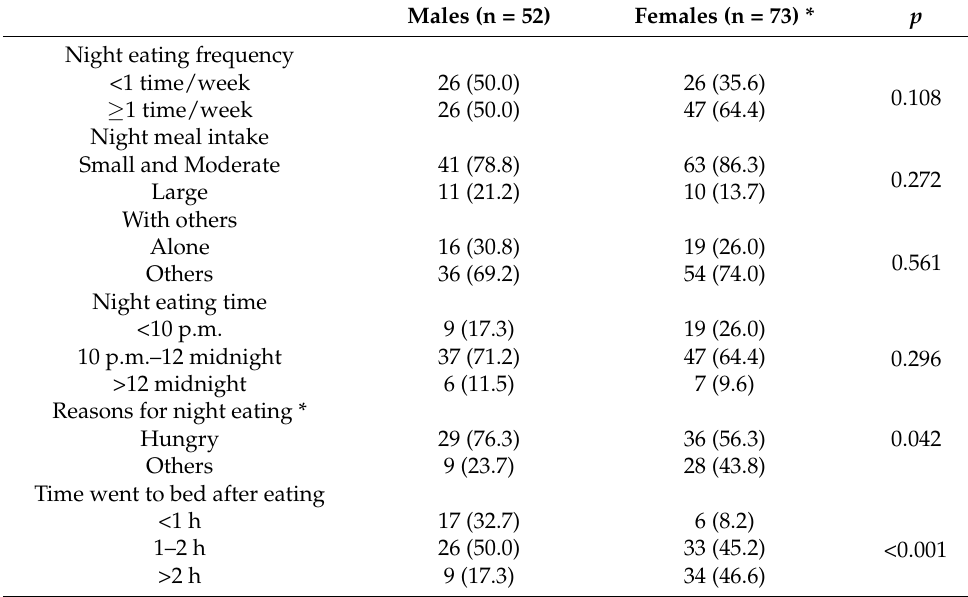
Table 2. Distribution of night eating habits by gender.